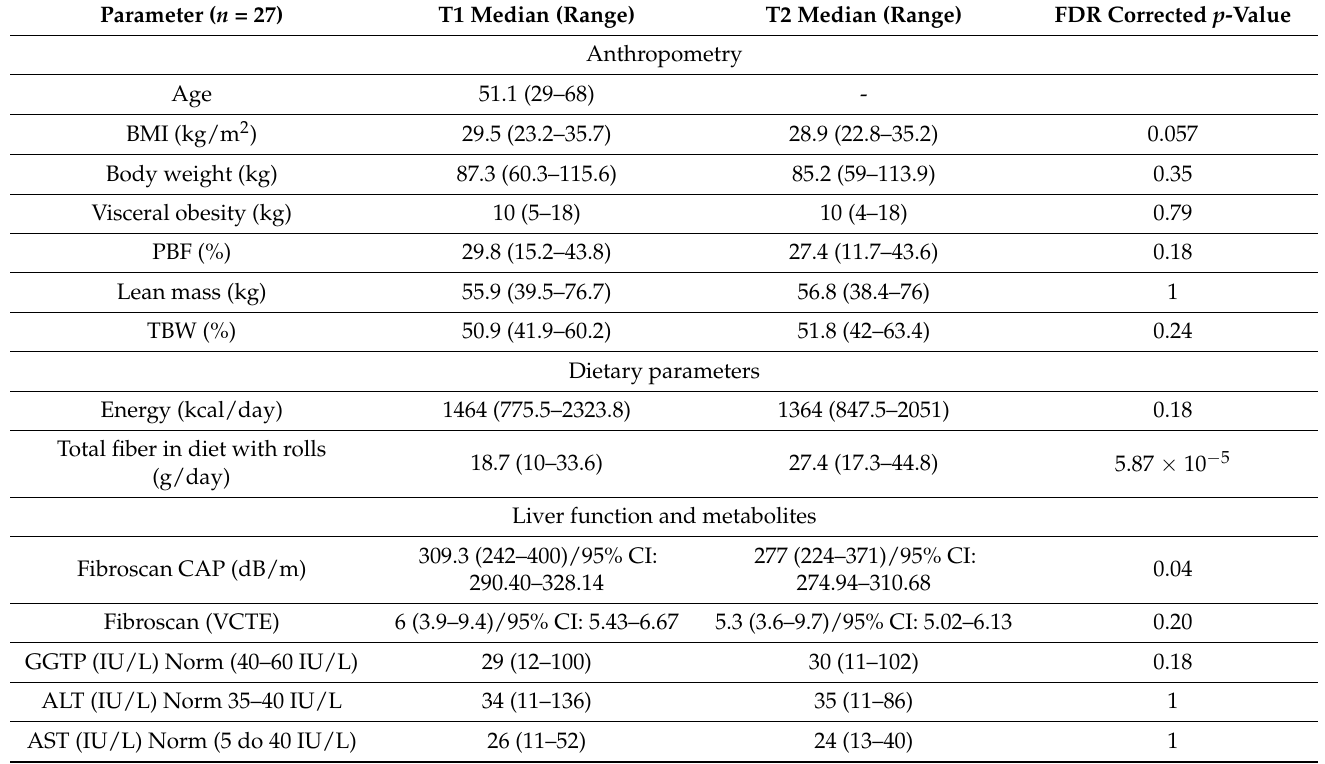
Table 1. Data on measurements taken in the study at baseline and